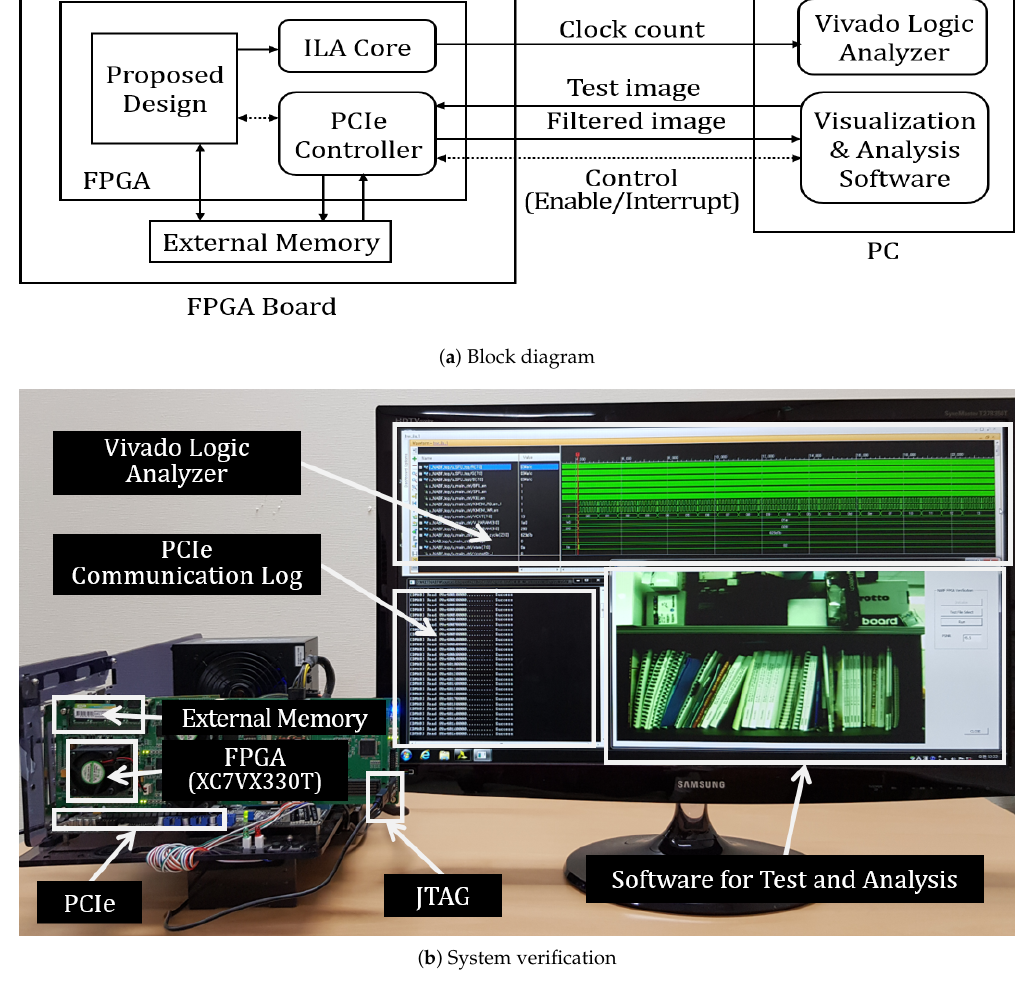
Figure 7. System configuration for the